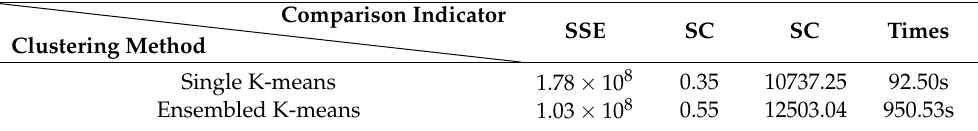
Table 3. Comparison index values of clustering results of ensembled K-means and single K-means of takeoffs.